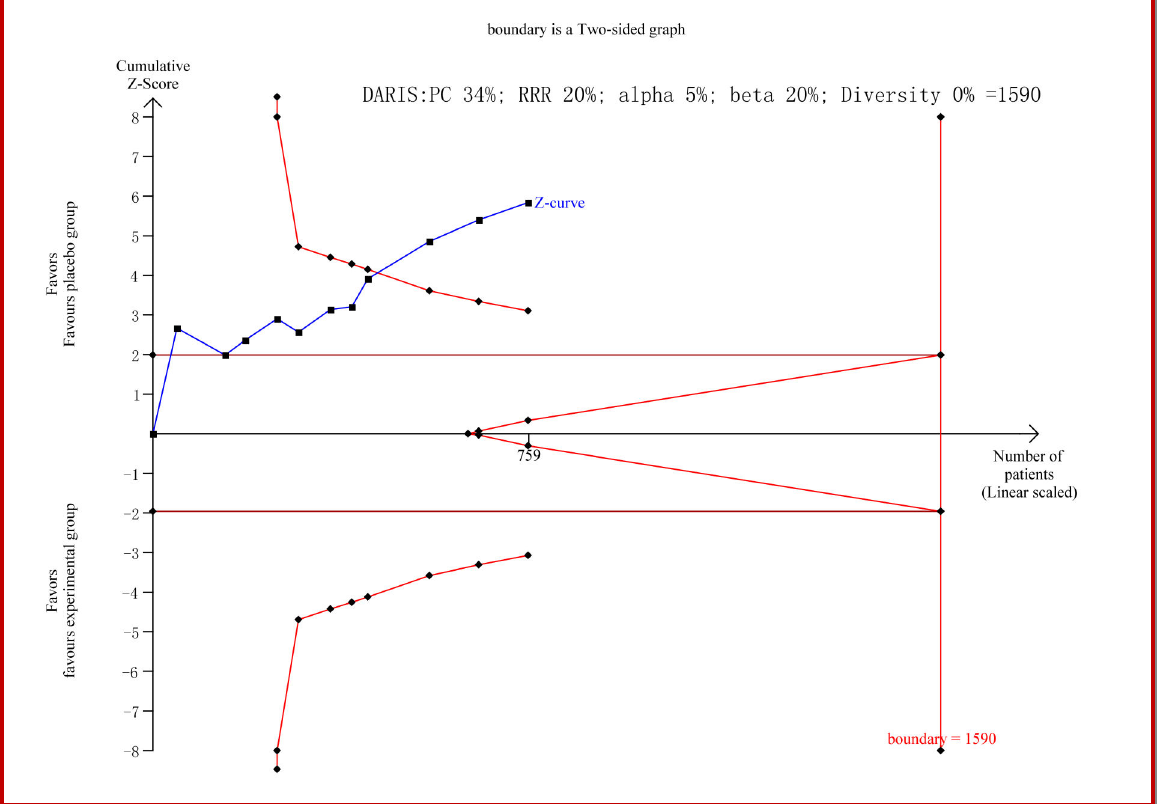
Figure 4: Trial sequential analysis for live birth rate between paternal or third-party lymphocyte and